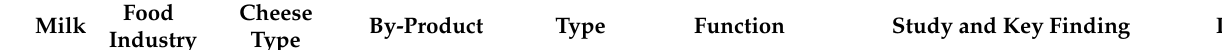
Table 2. Application of fruit and vegetable by-products in different